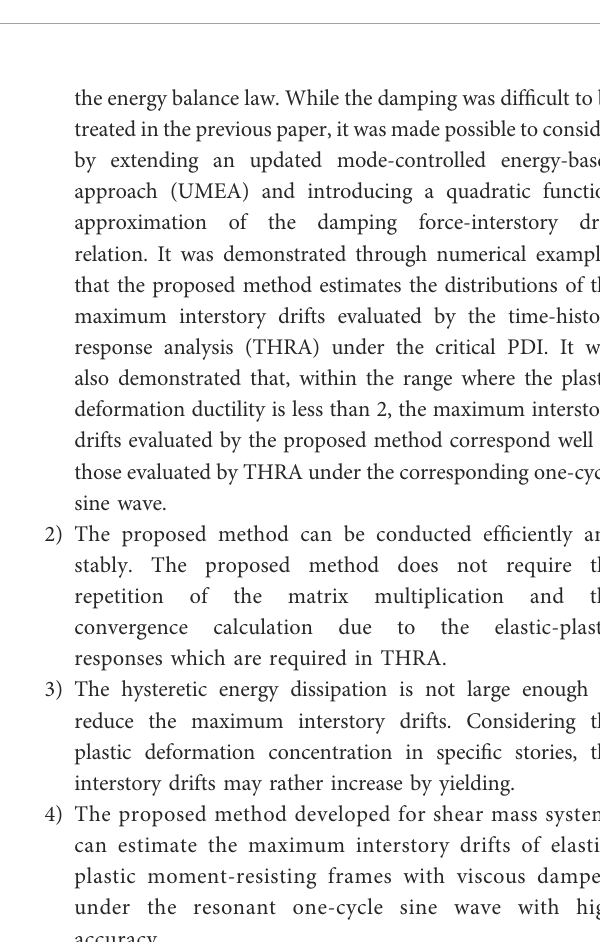
FIGURE 15 Maximum interstory drifts of moment-resisting frame and equivalent shear mass system under one-cycle sine wave and distribution of added damping coef fi